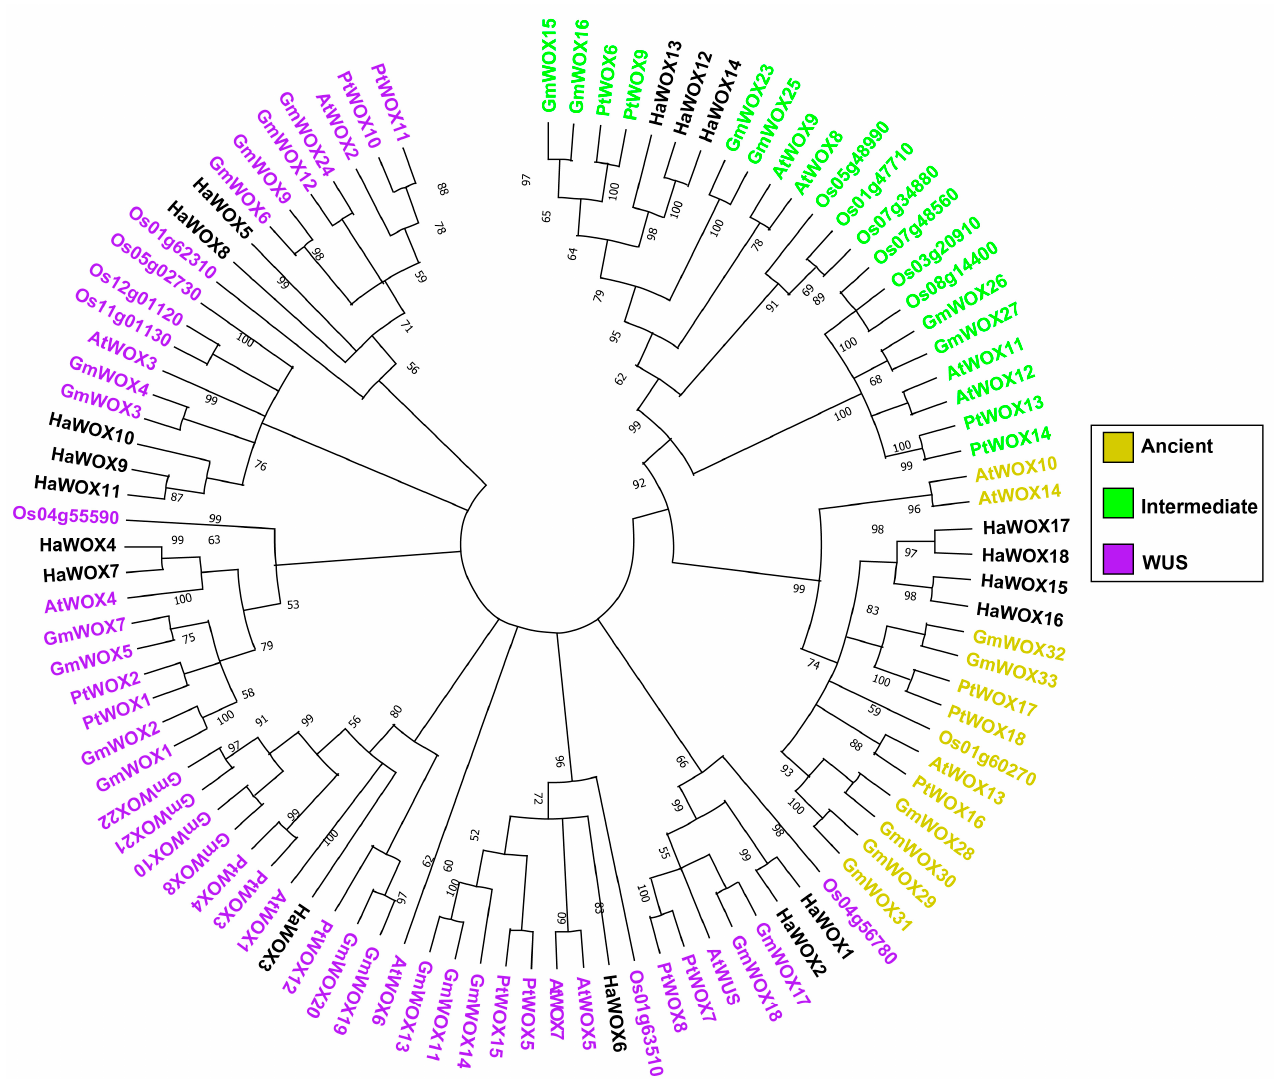
Figure 1. WOX phylogenetic tree for Glycine max (GmWOX), Populus trichocarpa (PtWOX), Arabidopsis thaliana (AtWOX), Oryza sativa (OsWOX), and Helianthus annuus (HaWOX). In the tree, sunflower WOXs are in black characters.